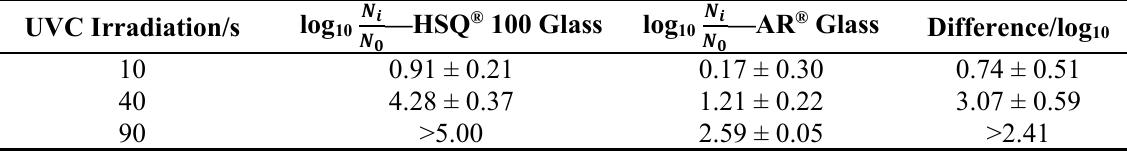
Figure 12. Disinfection results expressed in log 10 levels for E. coli (1–3 × 10 6 CFU/mL) with additional mixing during UVC irradiation. Table 3. Inactivation results for HSQ ® 100 and AR ® glass types for E. coli DSM 498 after different UVC irradiation periods and the corresponding differences of microbial inactivation in log 10 in mixed